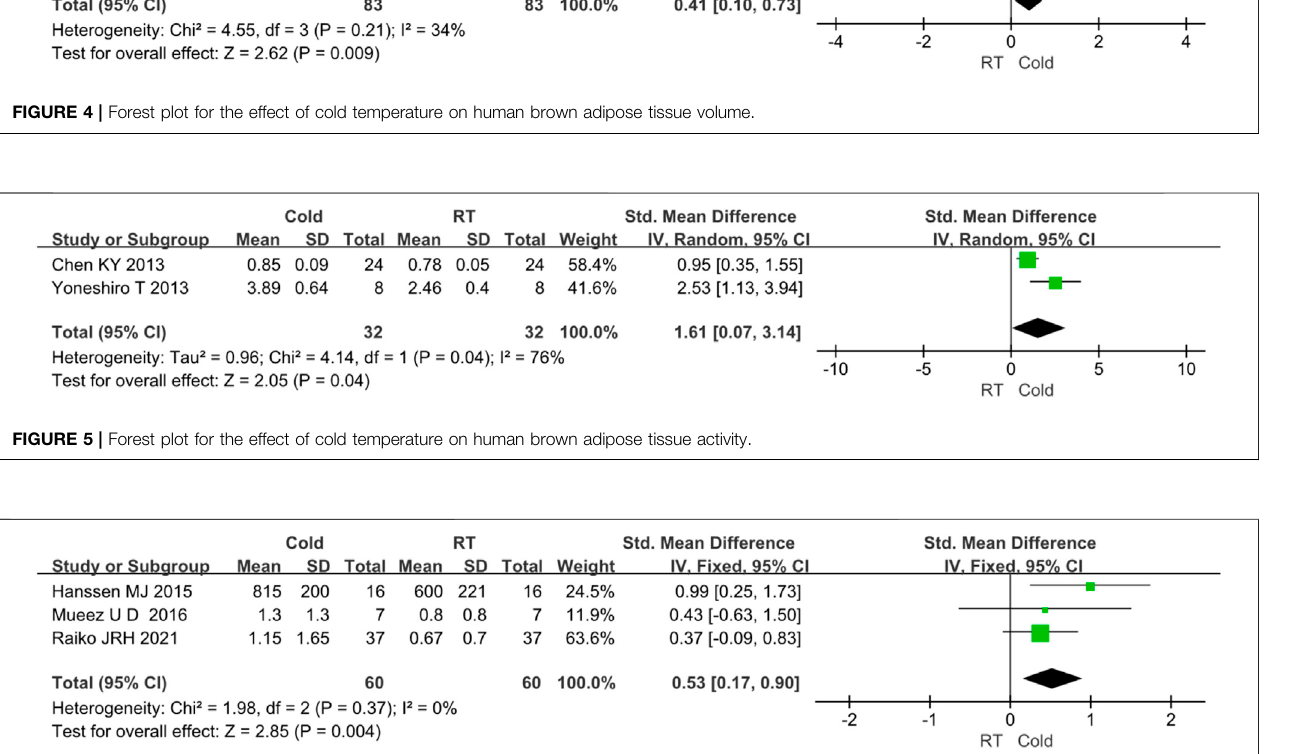
Frontiers in Physiology |